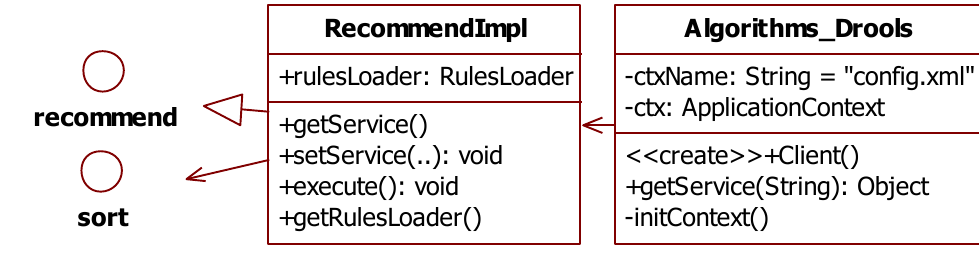
Figure 11. The UML diagram of drools-based recommendation